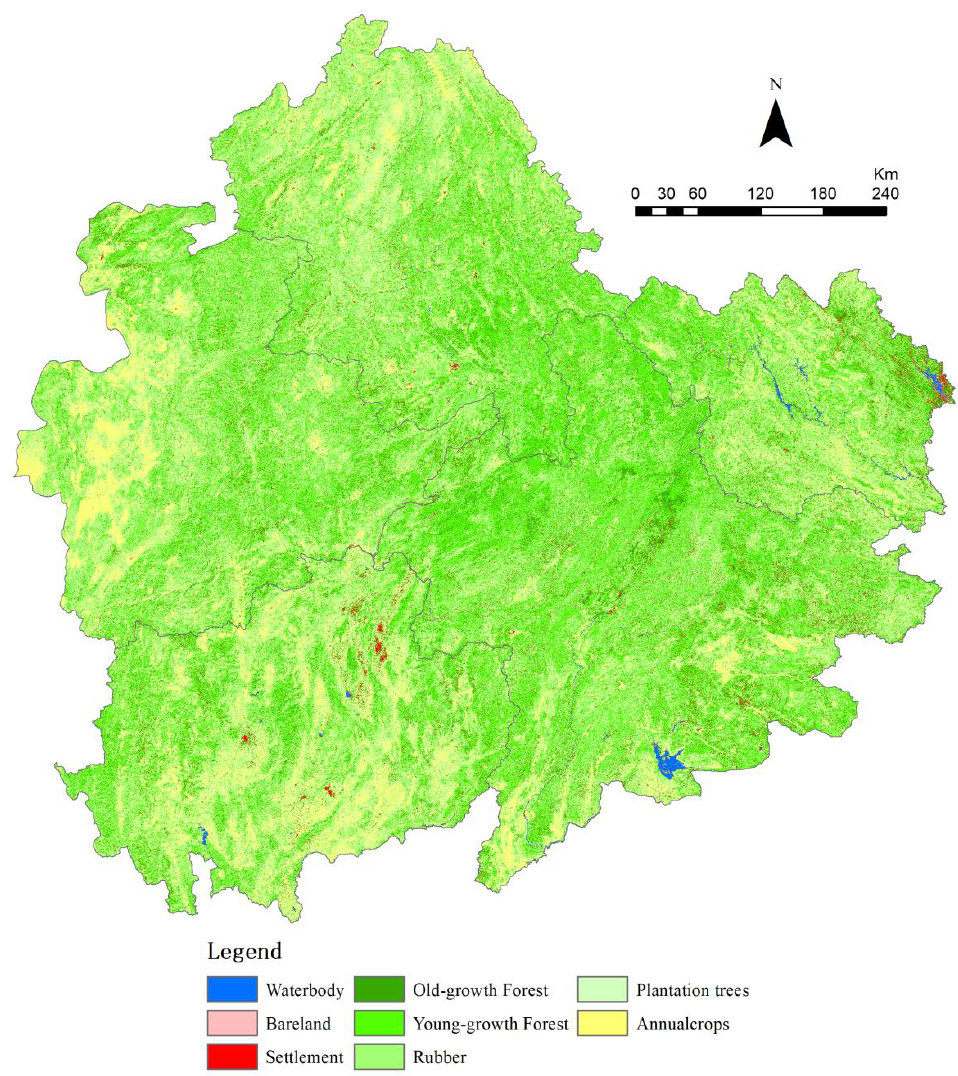
Figure 2. Land use/cover map in 2018.